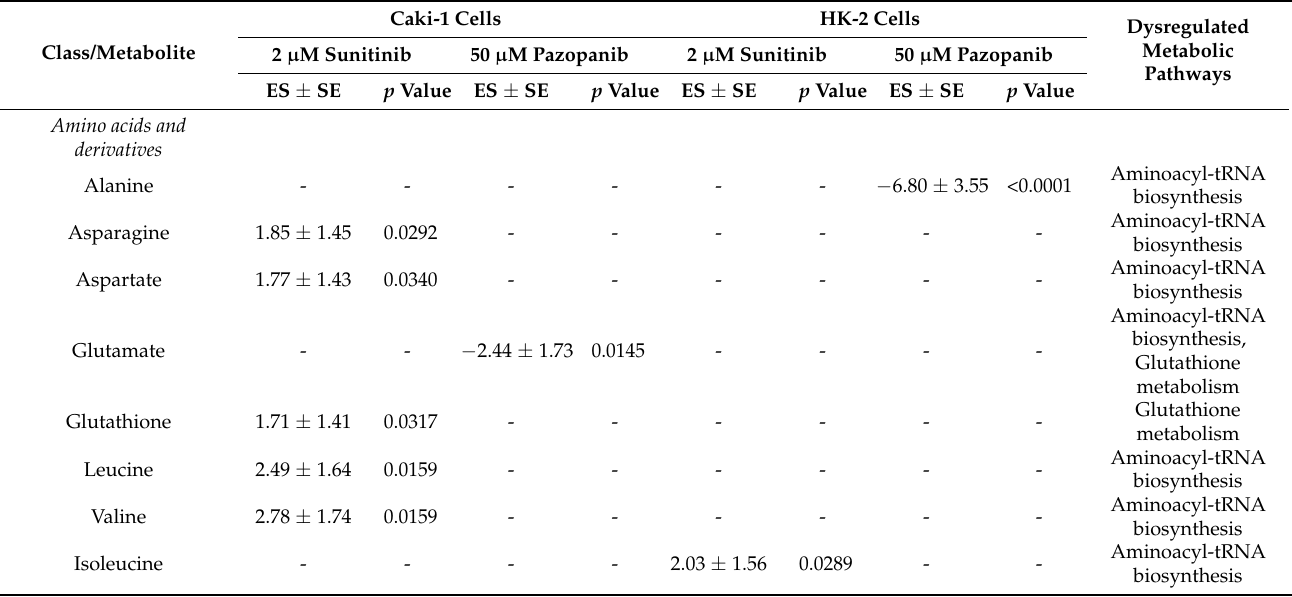
Table 1. List of metabolites significantly altered in the endometabolome of Caki-1 and HK-2 cells after exposure with 2 µ M sunitinib or 50 µ M pazopanib in comparison with the corresponding non-exposed cells